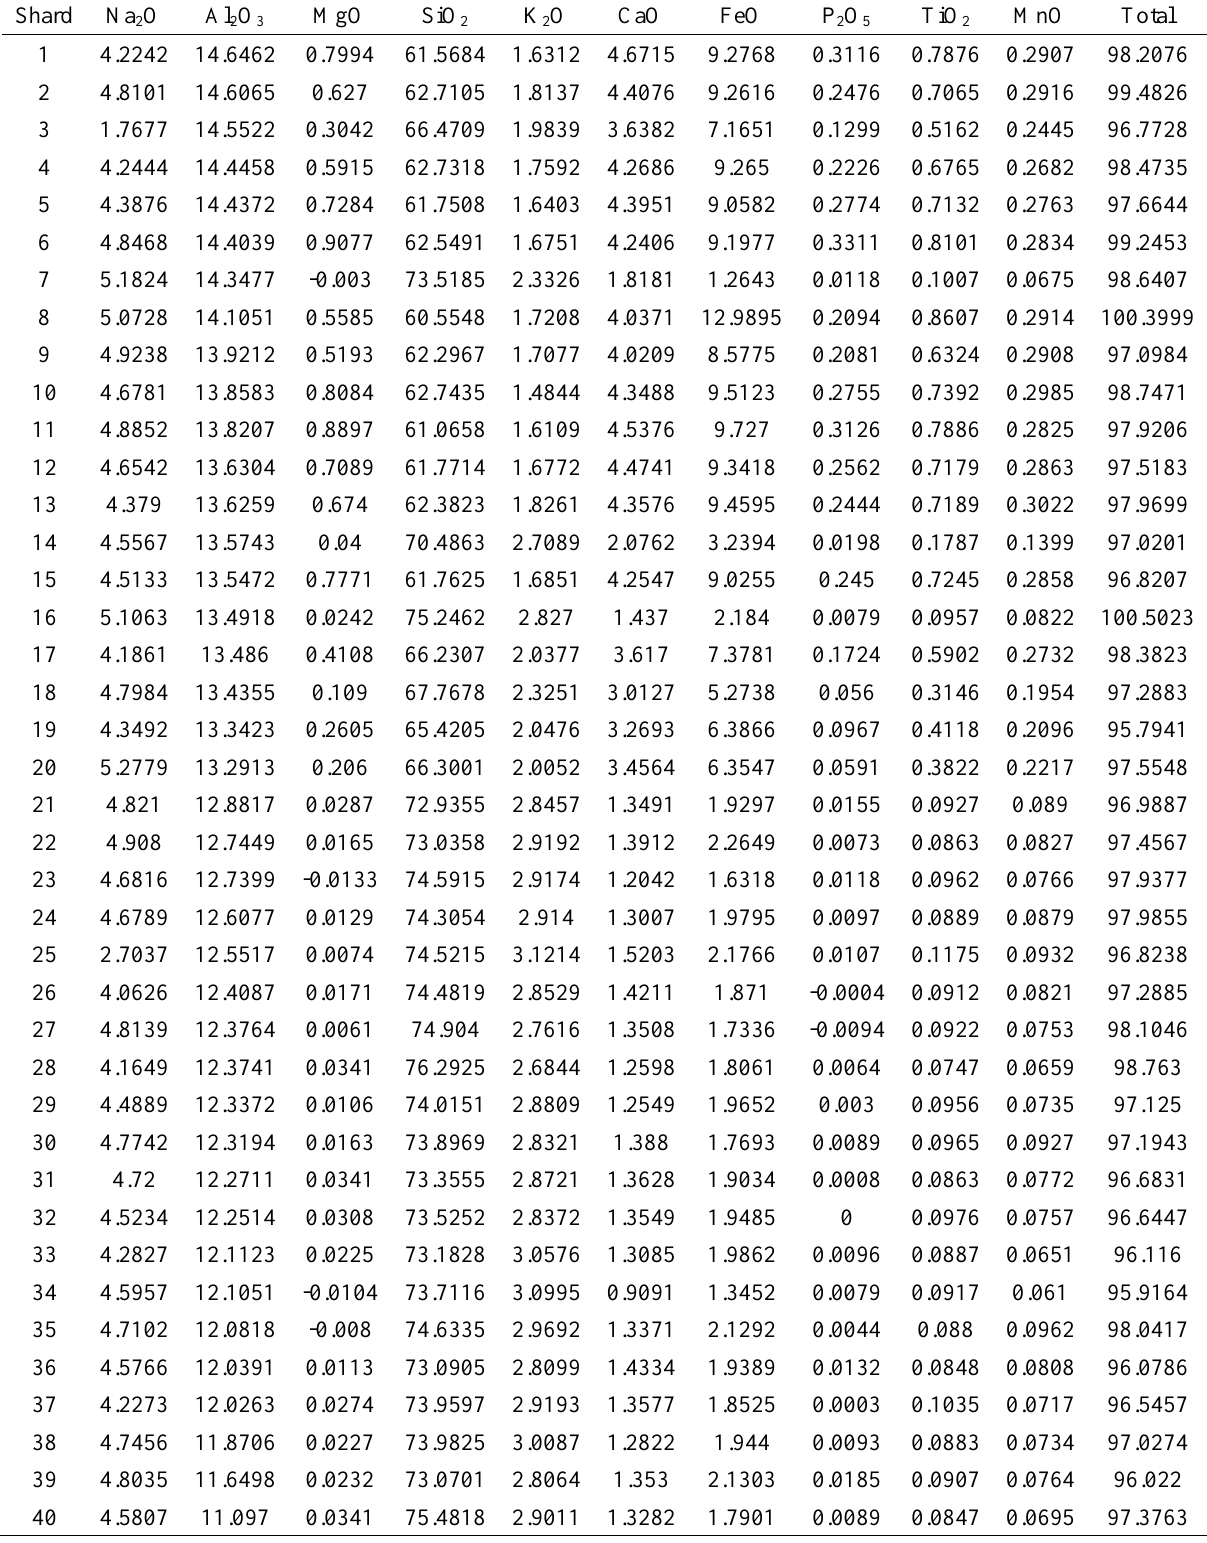
Table A2. Geochemistry from electronmicroprobe analysis of tephra shards found in the Catanach Forest core at 97 cm, identified as Hekla